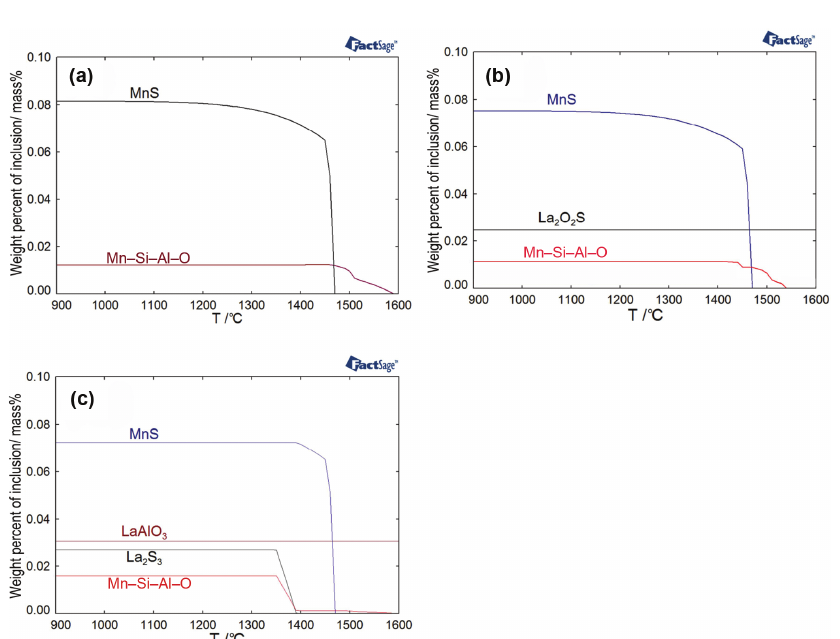
Figure 2: The microstructure in La-treated C – Mn steel with different Mn content